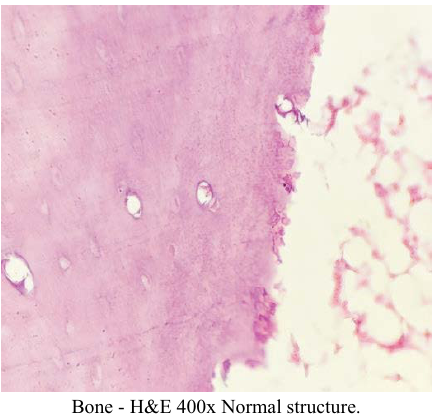
Bone - H&E 400x Normal structure. Fig. 8. Histopathology of decalcified bone of group 8 (Nigella in diab.Group) .